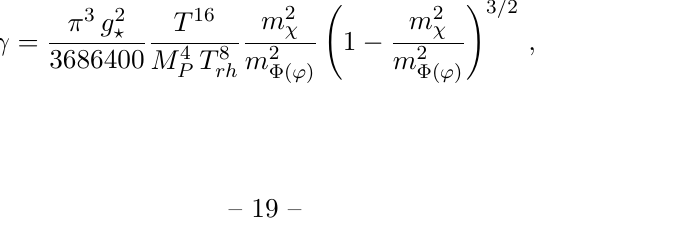
4 MeV, (b) stabil- rh > 1 . 83 × 10 9 GeV (for Model II) rh ’ must be < m 2 χ Φ / & (2 m ) /m or rh Φ χ